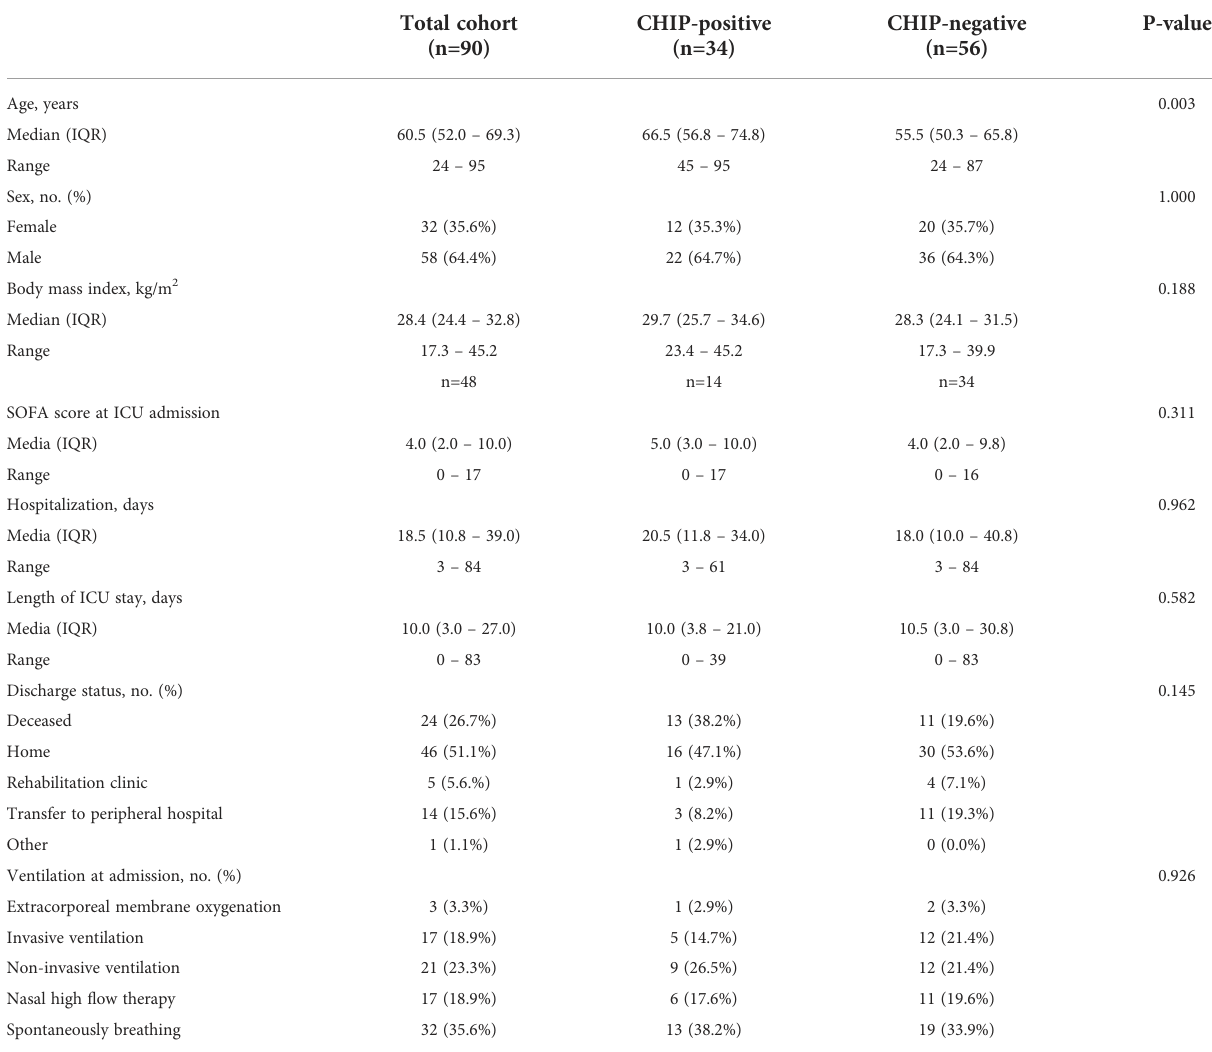
TABLE 1 Baseline